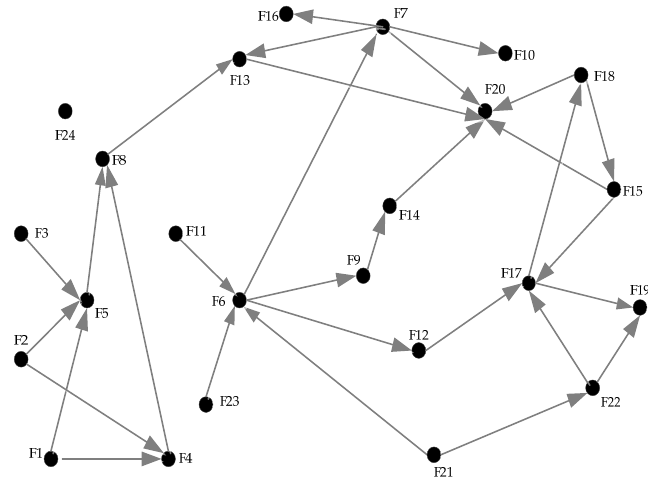
Figure 3. Relationships among factors.